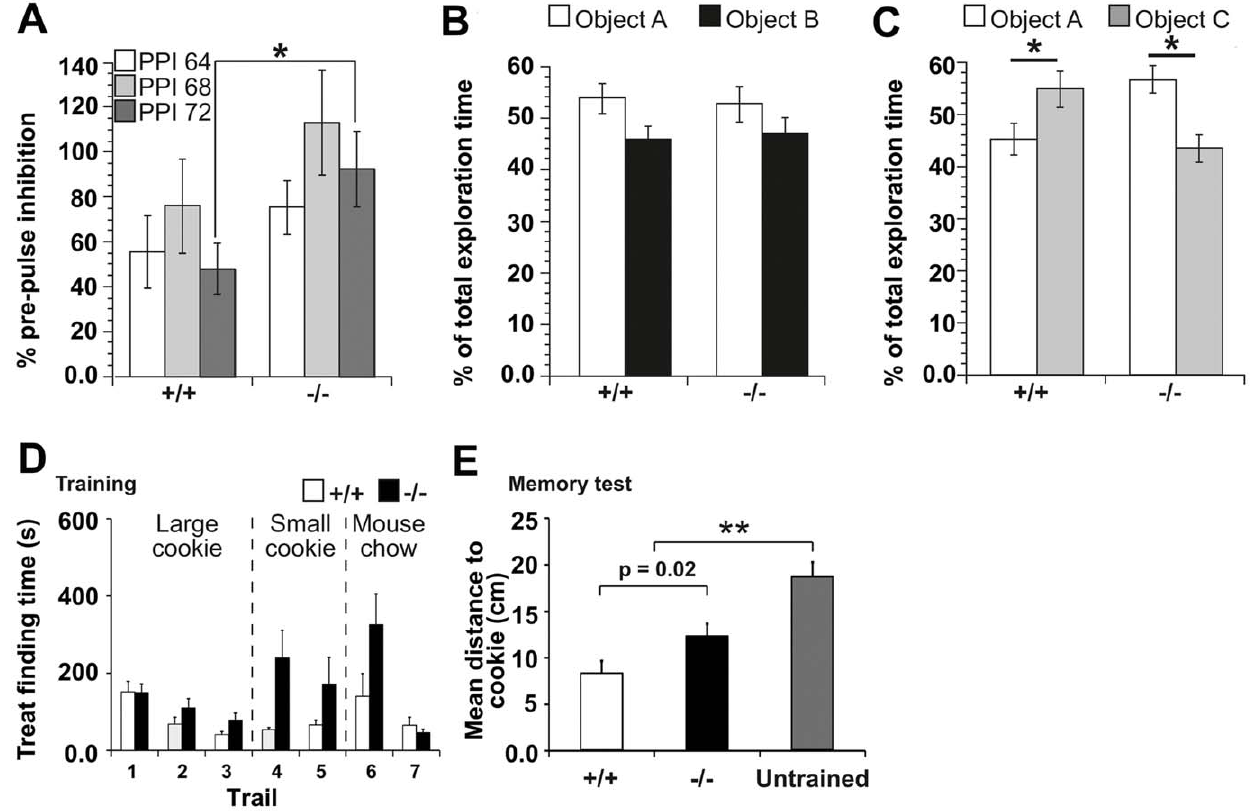
Figure 5. Behavioral dysfunctions of Panx1 2 / 2 mice. a, Pre-pulse inhibition of the acoustic startle response (PPI) showing a tendency towards lower levels in Panx1 2 / 2 (n=8) compared to Panx1 + / + (n=6) mice at the intensities of 62 and 64 dB. At the intensity of 72 dB, a statistically significant reduction of the PPI is detected. b, Object recognition was equivalent in both Panx1 + / + and Panx1 2 / 2 mice when the animals were allowed to explored two novel objects (A and B) for 5 minutes. c, One hour later control Panx1 + / + mice explored the now familiar object A significantly less than the novel object C. By contrast, Panx1 2 / 2 animals explored object C with significantly less intensity than object A. d, Cookie finding test: Training trials were performed on seven subsequent days, where in trial 1 and 2 a large cookie was used (500 mg), in trial 4 and 5 a smaller cookie (50 mg), and in trial 6 and 7 replaced by a very weak-odorous mouse chow. The time till the mice held the treat in their front paws is depicted in the bar diagram. Panx1 2 / 2 performed equal to Panx1 + / + mice in this experiment (P . 0.05, Student’s t-test) e, A further trial was performed after training trails where no treat was hidden (Movie S1). Bar graphs depict the mean distance of the mice to the location where the cookie was hidden during training trials for the first 60 s. Error bars represent SEM. n=9 for each mouse group. Panx1 knock out mice have an impaired memory, as they spent less time searching at the correct position (P=0.02). However, they still remembered the former location to some extent, as they spent significantly more time searching at the correct position as untrained animals (P , 0.001, Student’s